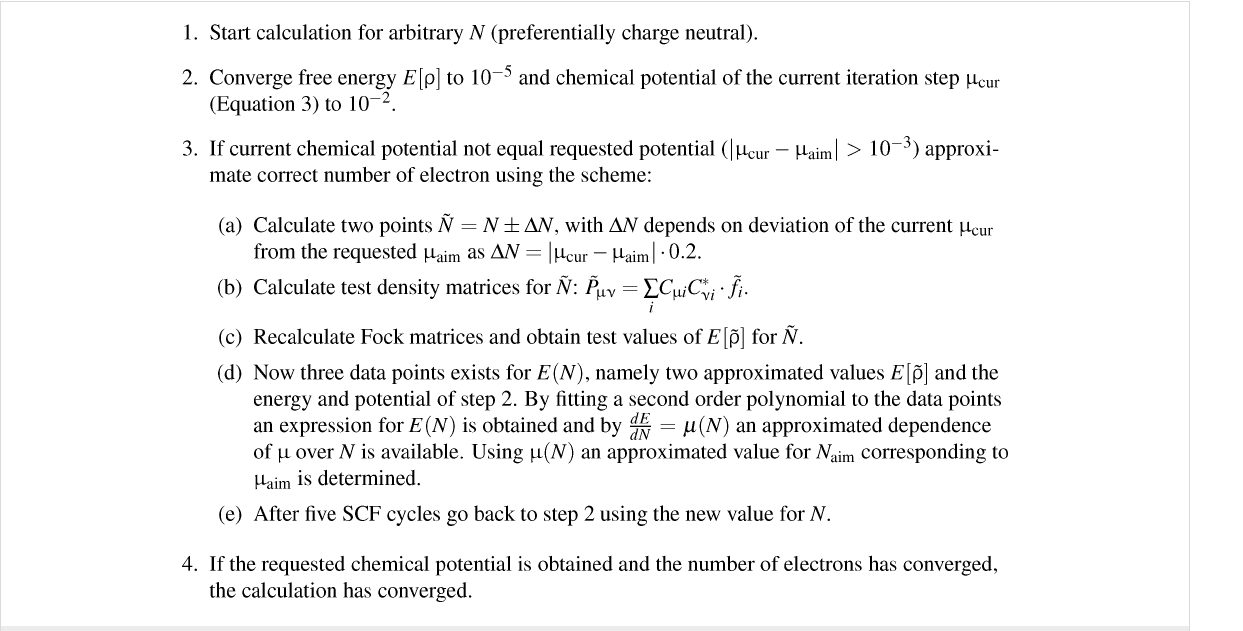
Figure 4: Scheme for a potential dependent calculation of the free